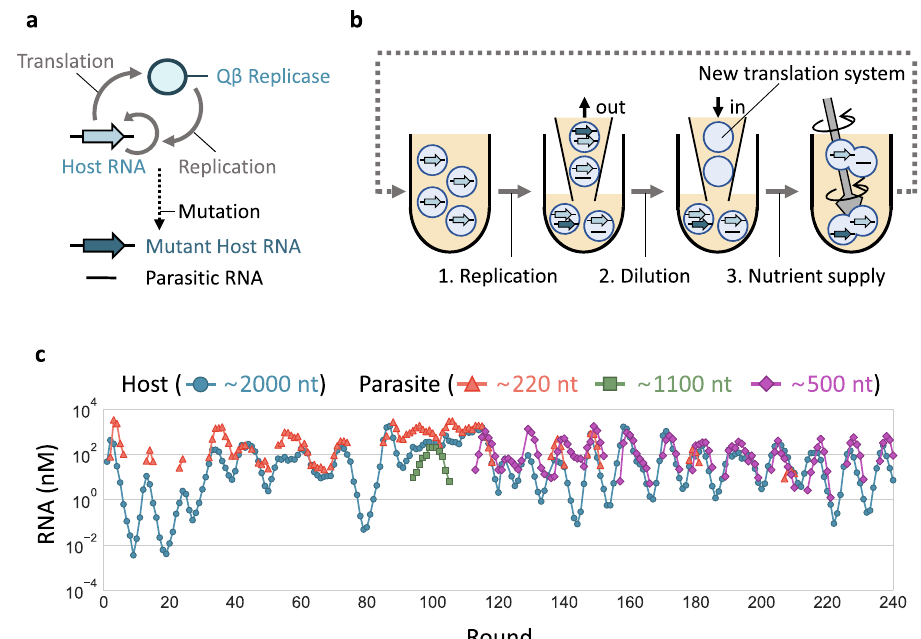
Fig. 1 Long-term replication experiment. a The RNA replication system. The original host RNA replicates via translation of the self-encoded replicase, by which mutant host RNAs and parasitic RNAs could be generated. b Schematic representation of long-term replication experiments in water-in-oil droplets. (1) RNA replication was performed at 37 °C for 5 h. (2) Droplets were 5-fold diluted with new droplets containing the translation system. (3) Droplets were vigorously mixed to induce their random fusion and division. c Concentration changes of host and parasitic RNAs of different lengths. Host RNA concentrations were measured by RT-qPCR, and parasitic RNA concentrations were measured from corresponding band intensities after gel electrophoresis. Parasitic RNA concentrations were not plotted in rounds where they were